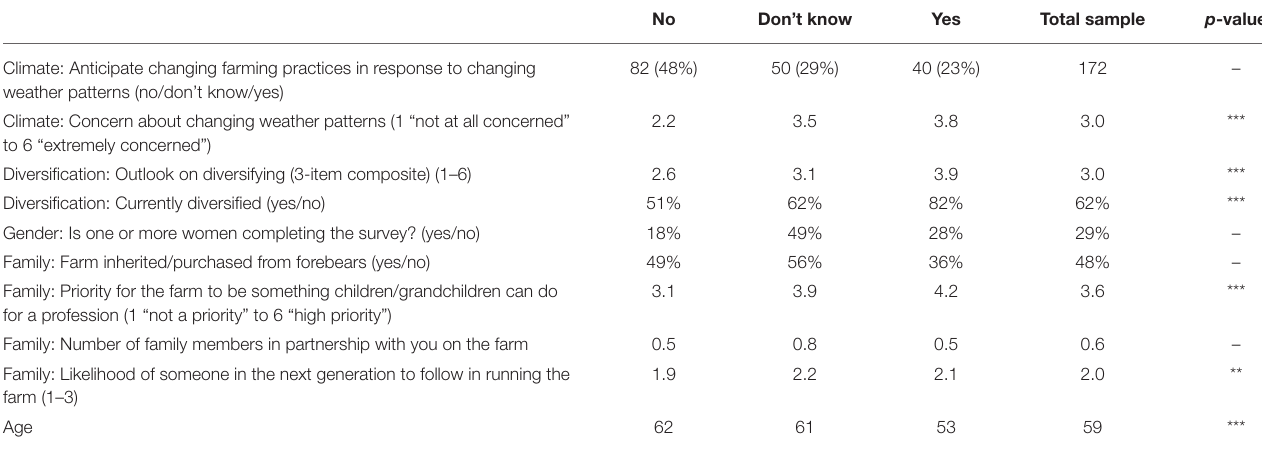
TABLE 5 | Research question 2: Do respondents anticipate changing farming practices in response to changing weather patterns? Analysis of their responses relative to other variables: Mean values. No Don’t know Yes Total sample p